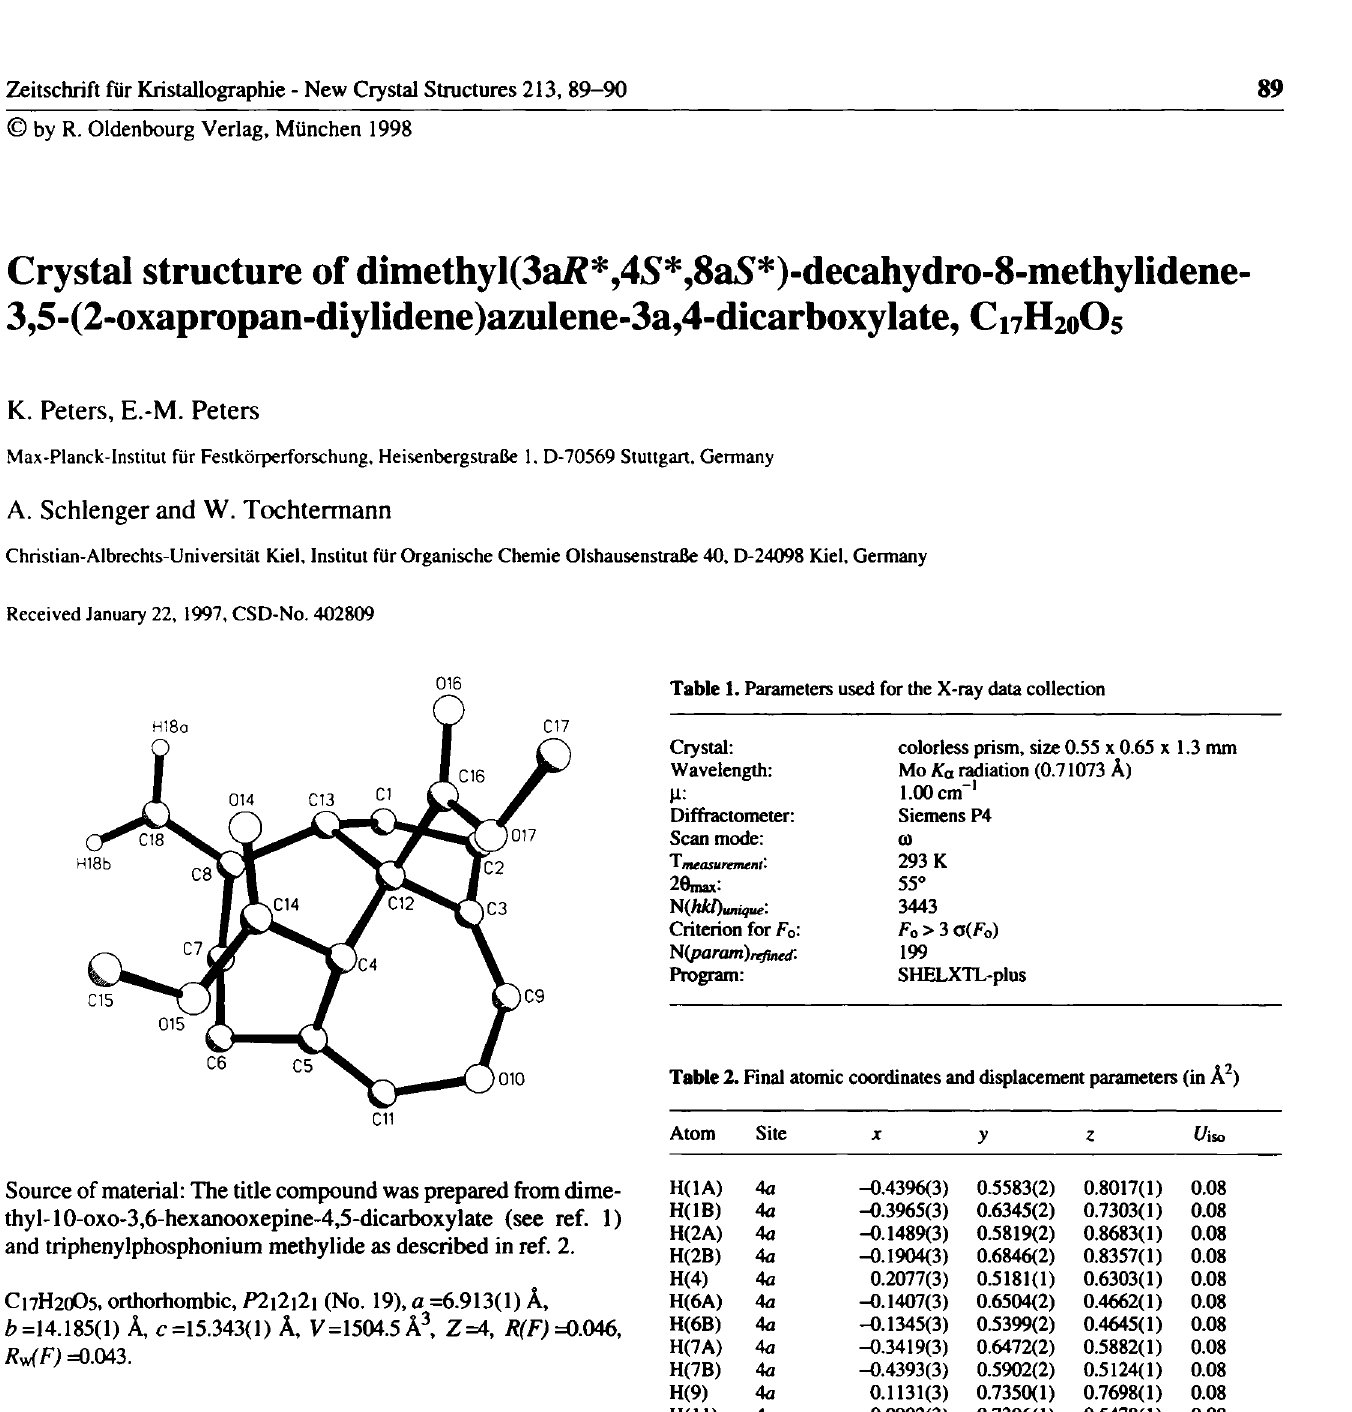
Table 2. Final atomic coordinates and displacement parameters (in Â^)